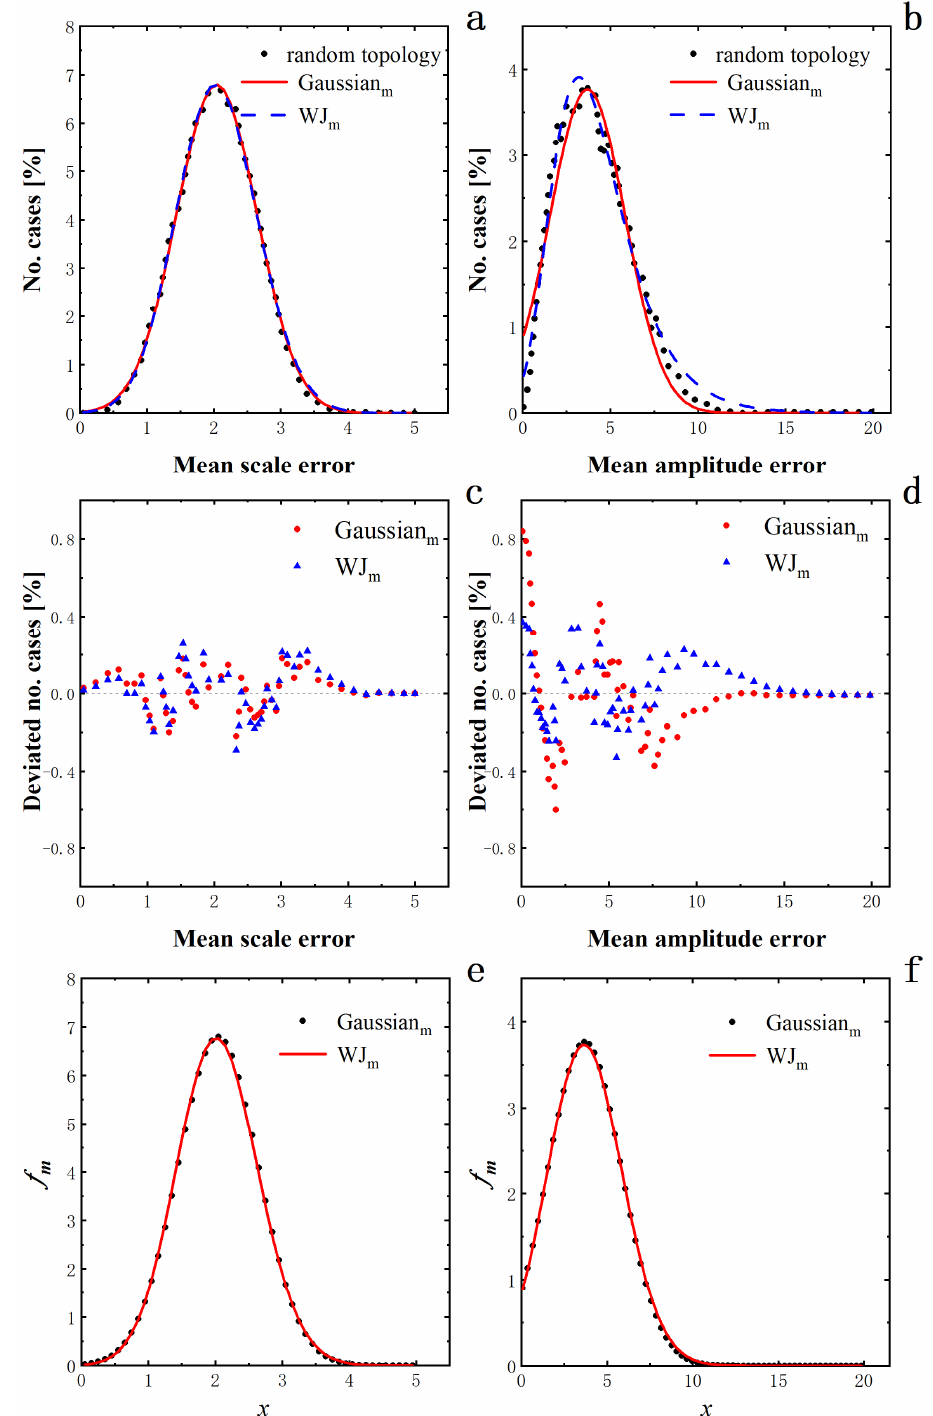
Figure 9. Comparative analyses of experimental data for different parameters obtained from the topi- cal medical studies. ( a ) Distribution of mean scale errors: Experimental data (dots), Gaussian function (continuous curve) and WJ distribution (dash); ( b ) Distribution of mean amplitude errors: Experi- mental data (dots), Gaussian function (continuous curve) and WJ distribution (dash); ( c ) Calculated deviations of mean scale errors: Gaussian function (dots) and WJ distribution (triangles); ( d ) Calcu- lated deviations of mean amplitude errors: Gaussian function (dots) and WJ distribution (triangles); ( e ) Fitting Gaussian function by WJ distribution for the case of mean scale errors: Gaussian function (dots) and WJ distribution (curve); ( f ) Fitting Gaussian function by WJ distribution for the case of mean amplitude errors: Gaussian function (dots) and WJ distribution